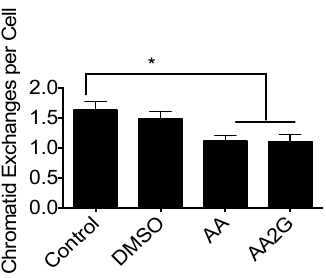
Figure 7. Effects of DMSO, AA, and AA2G for the UVC induced damages: Chromosomal aberration analysis, G1 exposed first post irradiation metaphase with 10 J/m 2 UVC. Error bars indicate standard error of the mean. * indicates statistically significant differences ( p < 0.05).